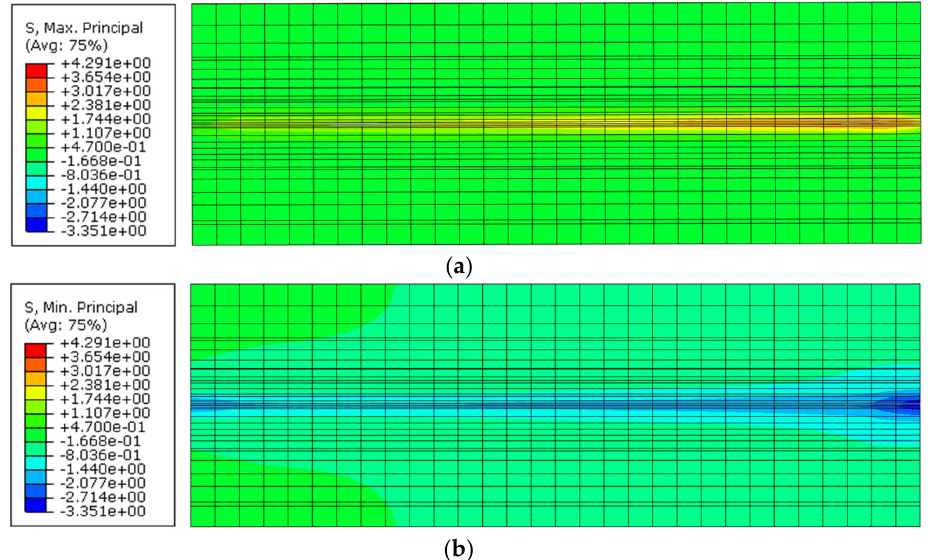
Figure 12. Principal stresses of the mortar: ( a ) maximum (tension) and ( b ) minimum (compres- sion).